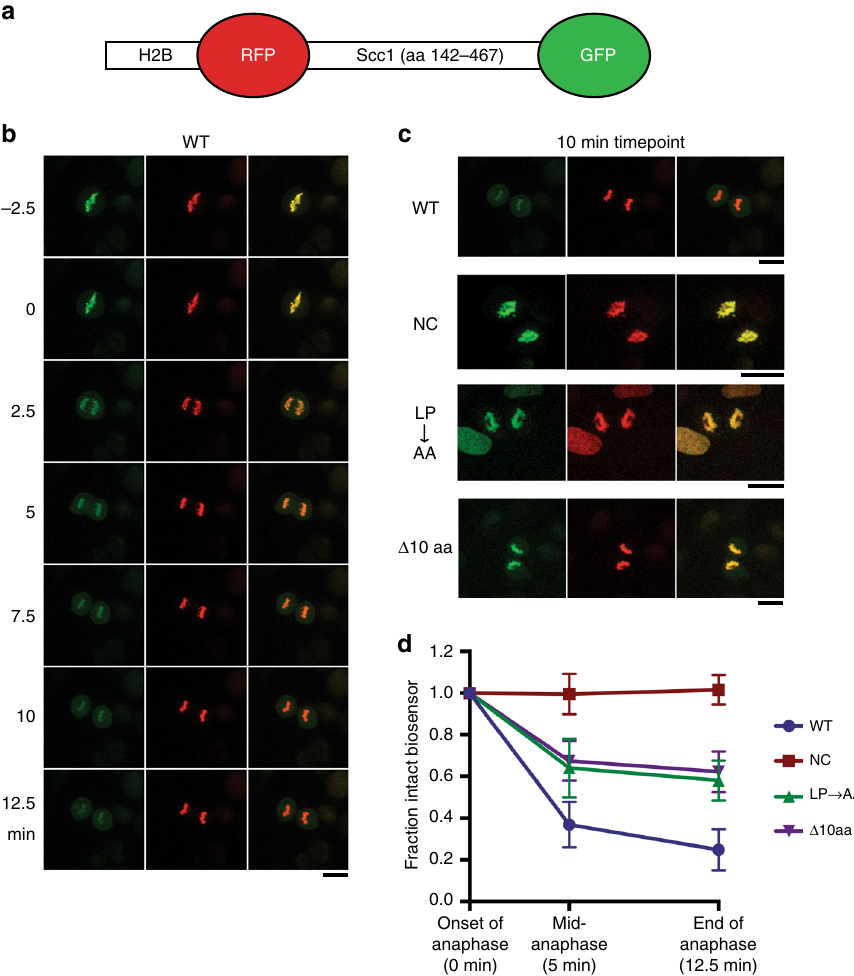
Fig. 3 The LPE motif is important for cleavage of a separase biosensor in vivo. a Schematic of the separase biosensor used to evaluate cleavage in vivo, which includes histone H2B, red fl uorescent protein (RFP), the indicated Scc1 fragment, and green fl uorescent protein (GFP) 33 . b Time course of wild-type (WT) biosensor cleavage by separase, showing green fl uorescence (left), red fl uorescence (center), and merged images (right). Time zero is the last time point before the onset of chromosome segregation. Biosensor cleavage is indicated by reduced green fl uorescence relative to red fl uorescence. Scale bar: 20 μ M. c Representative images showing late anaphase fl uorescence of biosensor variants carrying mutations in Scc1 (WT, wild-type, copied from a ; NC, non-cleavable mutations at sites 1 and 2; LP → AA, mutations of 255 LP; Δ 10aa, deletion of aa 251 to 260, which contain the LPE motif). Scale bars: 20 μ M. d Quanti fi cation of the loss of GFP fl uorescence in the four biosensor variants shown in c . Data points indicate means (±SD) from between 15 and 30 cells. Source data are provided in the Source Data fi